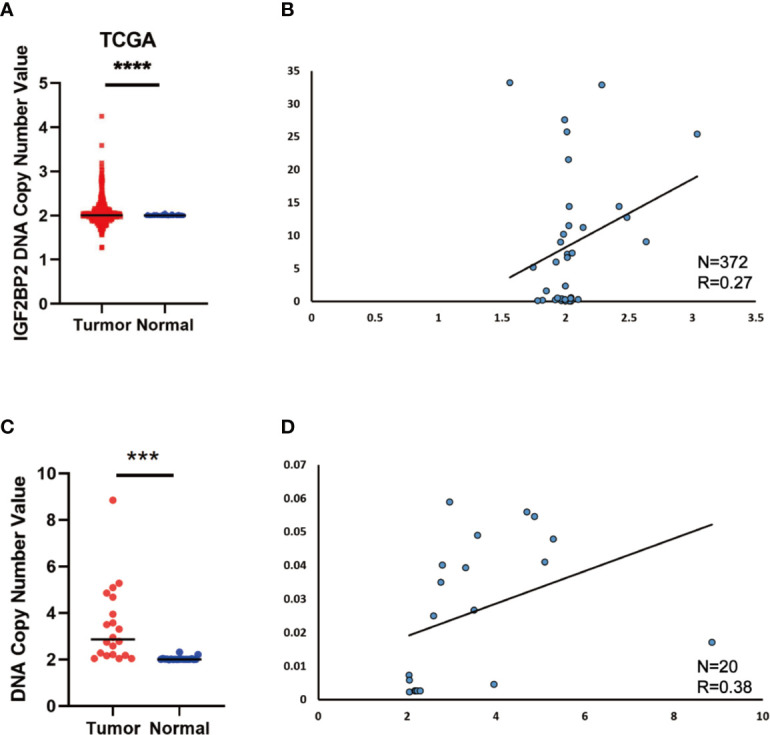
DNA Copy Number Aberrations Promote IGF2BP2 Overexpression in HCC. (A) IGF2BP2 copy numbers in the TCGA databases. (B) Correlation between the DNA copy number and mRNA expression of IGF2BP2 in TCGA. (C, D) The comparison of the IGF2BP2 DNA copy number between HCC tissues (T) and adjacent normal tissues (N) in 20 patients and the correlation between the DNA copy number and mRNA expression of IGF2BP2 in 20 HCC tissue. (****P < 0.0001, ***P < 0.001, Student’s t-test).